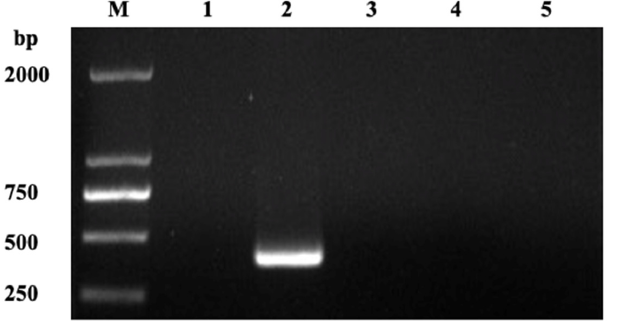
Figure 4. The specificity of nanoPCR. Lane M, DL 2000 Marker; Lane 1, negative control; Lanes 2–5, GPV, MDPV, DPV, and GPMV.